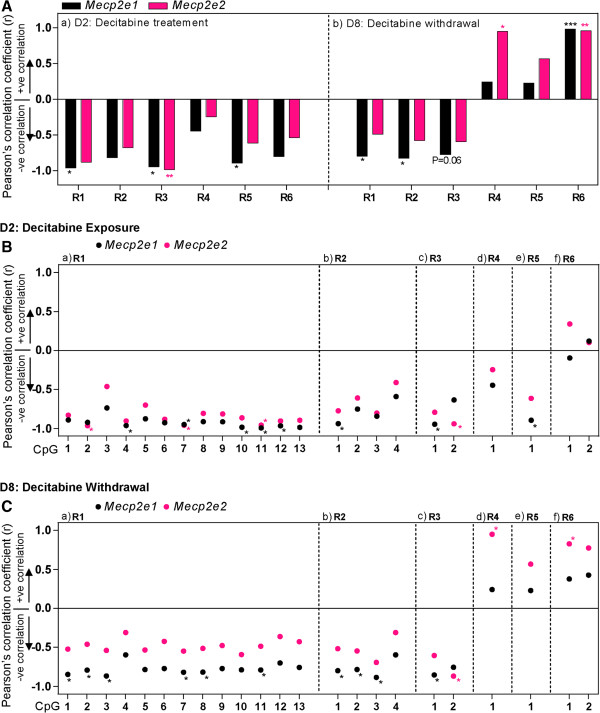
Correlation analysis between DNA methylation at the Methyl CpG binding protein 2 gene (Mecp2) regulatory elements and Mecp2 expression after decitabine treatment (day 2) and decitabine withdrawal (day 8). All graphs represent the Pearson's correlation coefficient (r) for Mecp2e1 (black), and Mecp2e2 (pink): statistical significance: ***P <0.001; **P <0.01; *P <0.05; n = 3. (A) Correlation coefficients for the relation between Mecp2 expression and average methylation over entire regions in Mecp2 promoter (region (R)1 to R3) and intron 1 (R4 to R6) after decitabine exposure on day 2 (D2) (a), and after decitabine withdrawal on D8 (b). (B) After decitabine exposure: correlation coefficients for Mecp2e1 (black), and Mecp2e2 (pink) with individual CpG methylation at the promoter regions (a) R1, (b) R2 and (c) R3, and intron 1 regions (d) R4, (e) R5 and (f) R6. (C) After decitabine withdrawal: correlation coefficients for Mecp2e1 (black), and Mecp2e2 (pink) with individual CpG methylation at promoter regions (a) R1, (b) R2 and (c) R3, and intron 1 regions (d) R4, (e) R5 and (f) R6. Statistical significance: *P <0.05; n = 3.